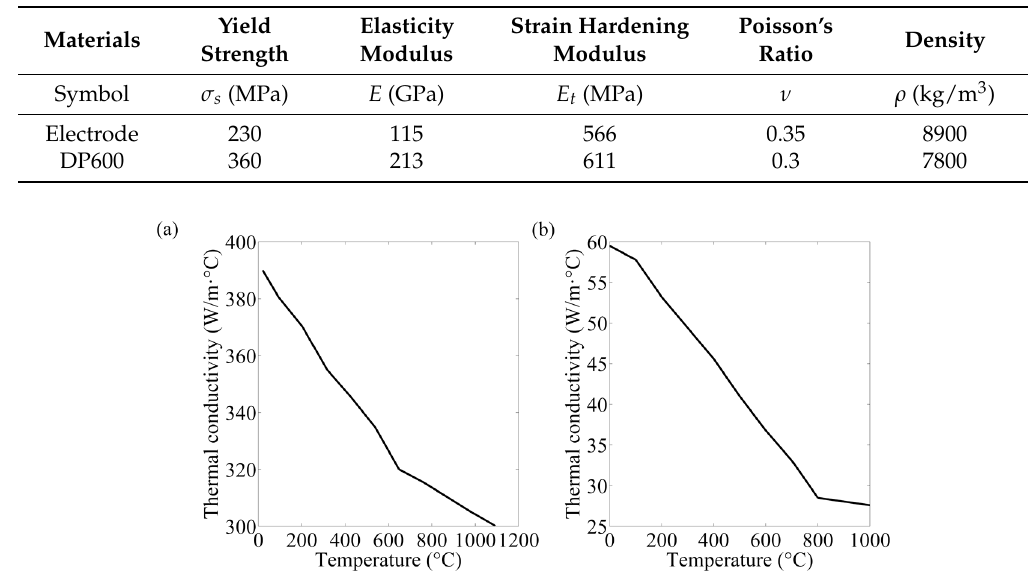
Table 3. Mechanical properties of electrode and DP600 at room temperature.